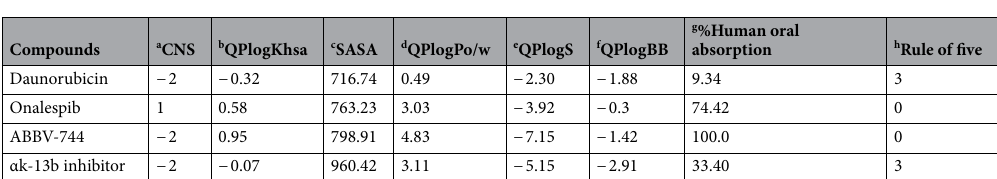
Table 2. In-silico ADMET screening of the selected compounds. a Predicted central nervous system activity from − 2 (inactive) to + 2 (active). b Prediction of binding to human serum albumin (acceptable range: − 1.5–1.5). c Total Solvent Accessible Surface Area: SASA (acceptable range: 300–1000). d Predicted octanol/ water partition coefficient (acceptable range: − 2–6.5). e Predicted aqueous solubility, S in mol/dm −3 (acceptable range: − 6.5–0.5). f Predicted brain/blood partition coefficient (acceptable range: − 3.0–1.2). g Predicted percentage human oral absorption (< 25% is poor and > 80% is high). h Number of violations of Lipinski’s rule of five, Compounds that satisfy these rules are considered druglike (maximum